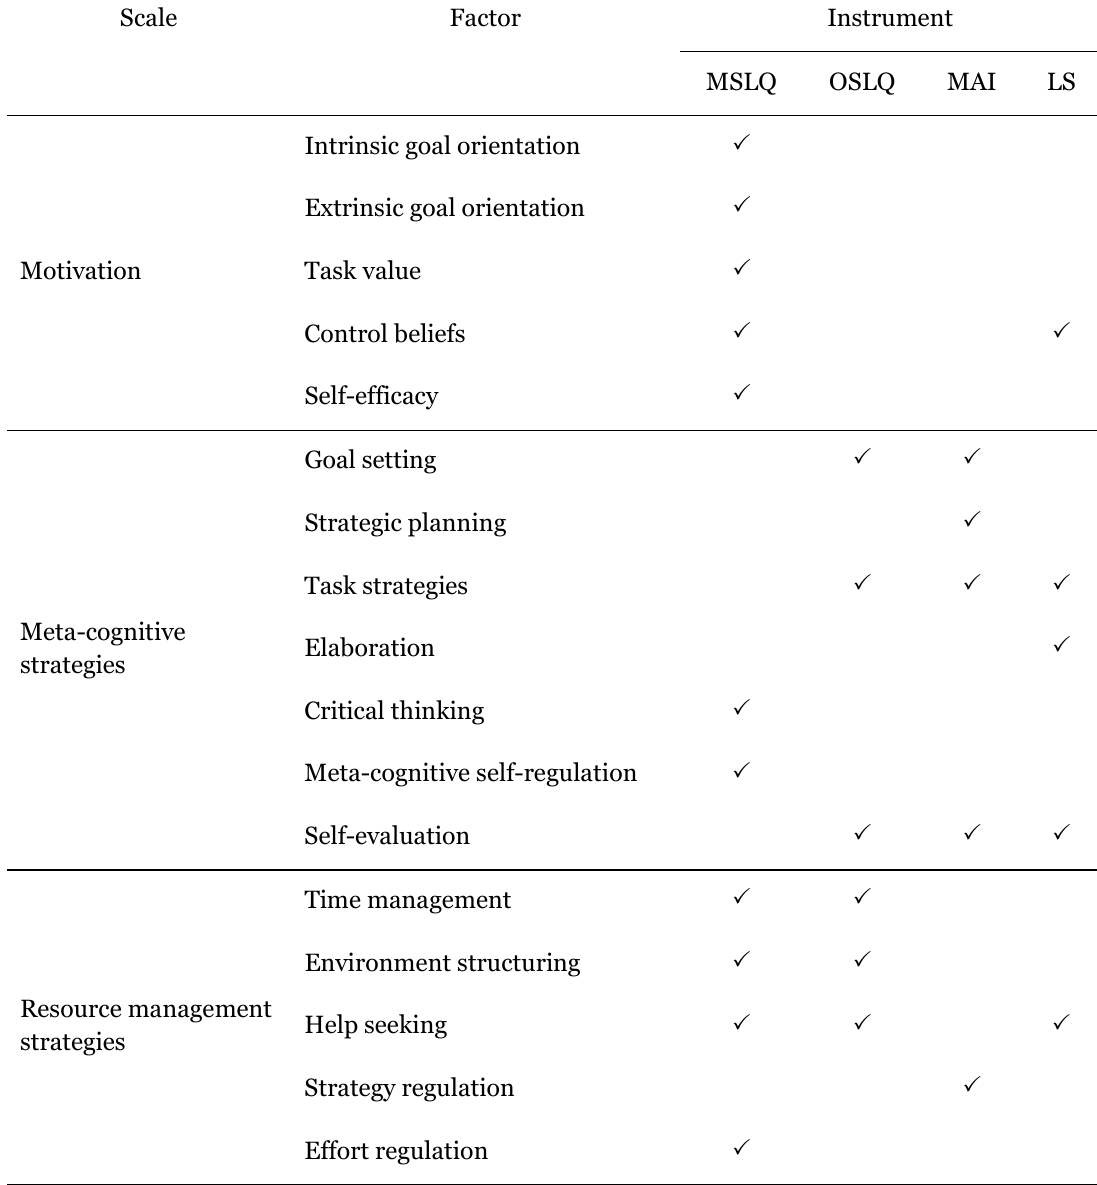
Table 3 Factors Related to MOOC Learners’ Motivation and Learning Strategies in MSLQ, OSLQ, MAI, and LS Scale Factor Instrument